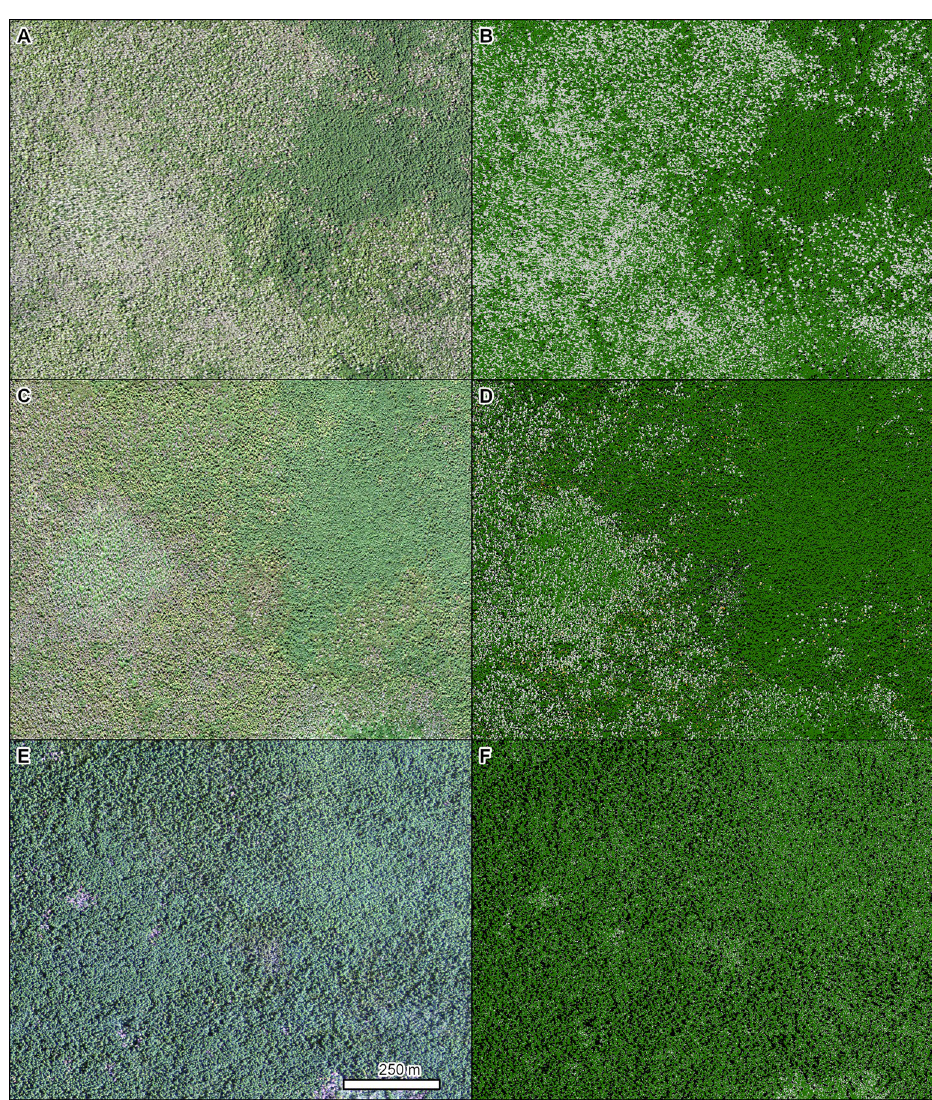
Fig 6. Mortality of tamarack ( Larix laricina ) caused by Eastern larch beetle ( Dendroctonus simplex ). Left panels are NAIP imagery from 2019 (A), 2017 (C), and 2013 (E). Right panels (B, D, F) are the corresponding TCH model results from each year (orange = red crowns, light gray = gray crowns, dark green = green crowns, black = shadowed crowns). Note: The red crown color class is difficult to see at this map scale, but it mostly exists in panel D. Location: Northern Minnesota. Insect and Disease Survey database DAMAGE_AREA_ID: {83accf7a-04b6-4f34-8e8e-4ab2770b42df}. NAIP imagery (public domain) provided by USDA-FSA-APFO.